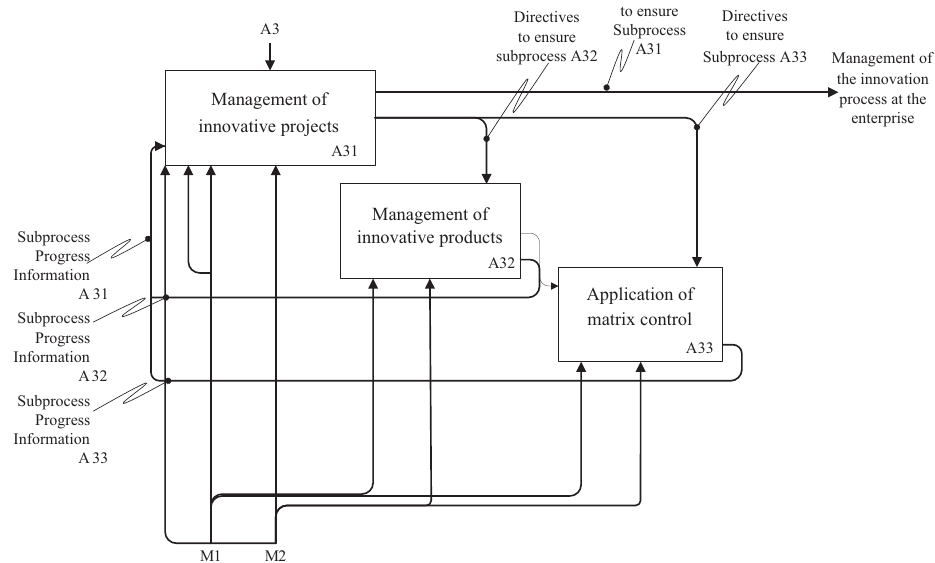
Figure 6. The decomposition of the functional model for achieving the process